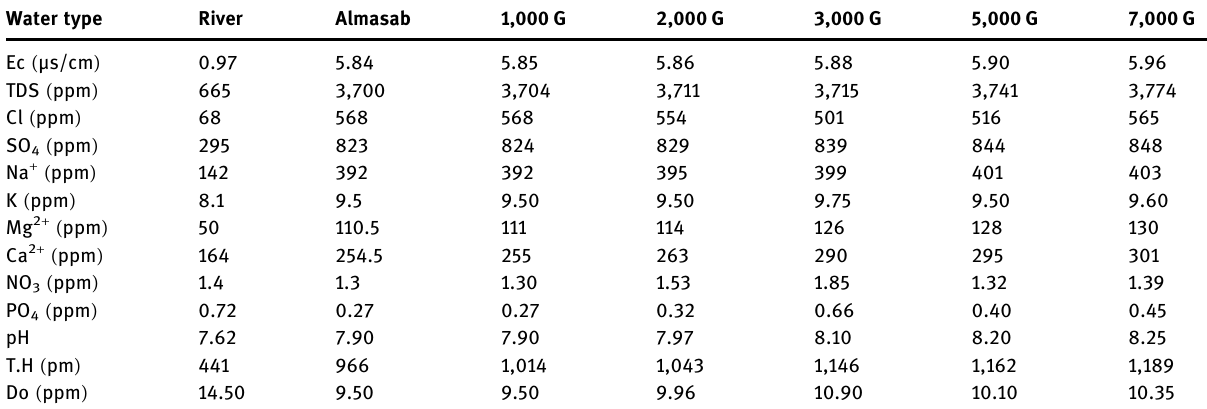
Table 1: The average characteristics of the studied river and saltwater from Almasab Alam drainage before and after the magnetization Water type